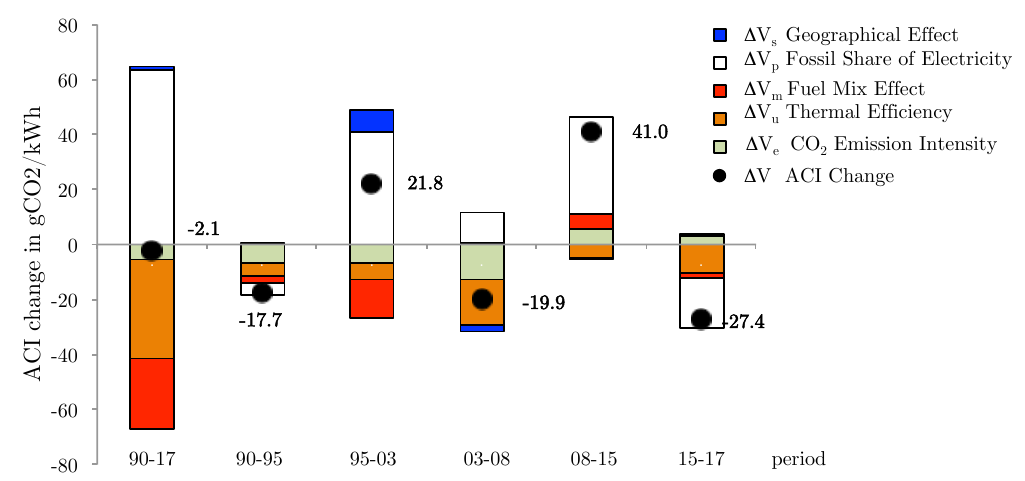
Figure 5. Additive IDA-LMDI analysis considering five periods (gCO 2 /kWh).